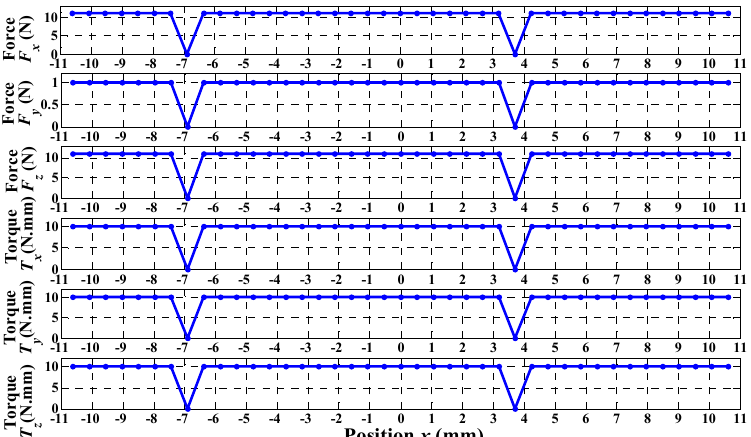
Figure 16. Electromagnetic forces and torques generated from optimization commutation currents with boundary constraint I m = 1.95 A.